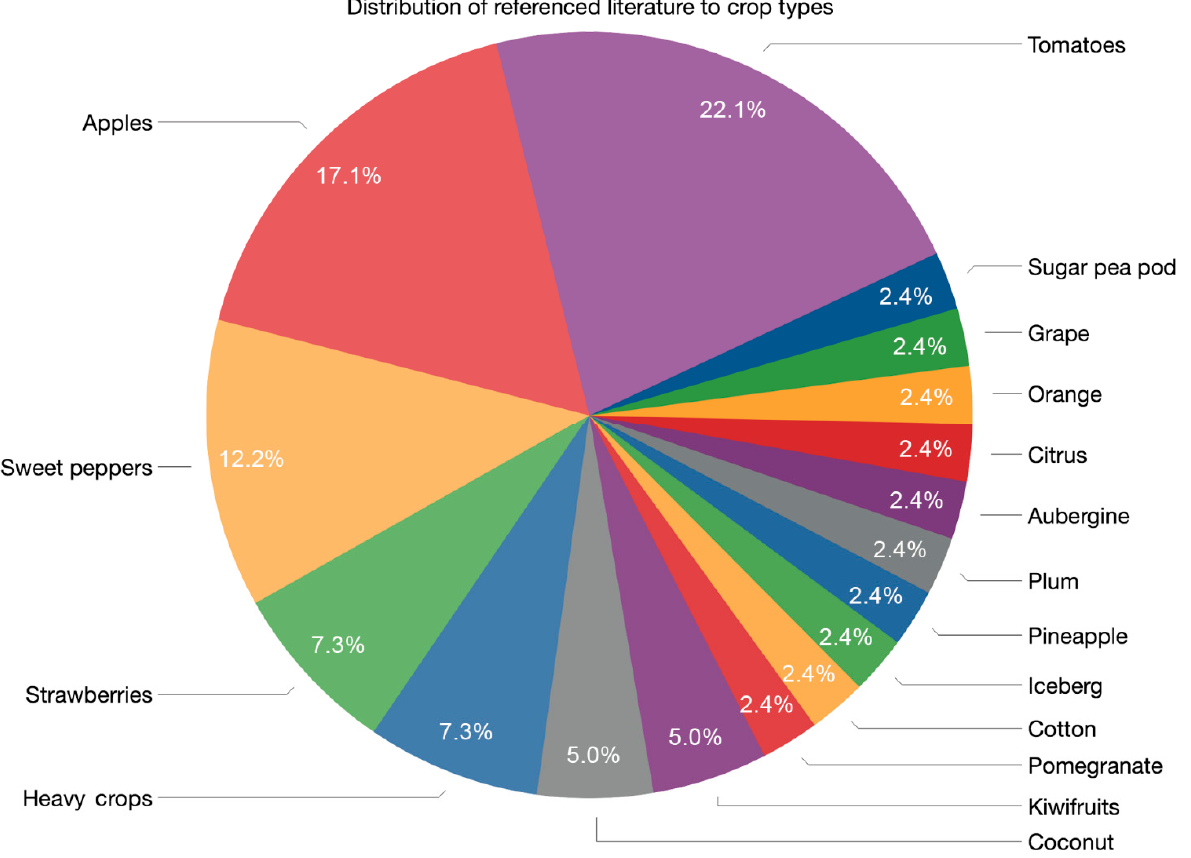
Figure 10. Distribution of referenced literature per crop type.